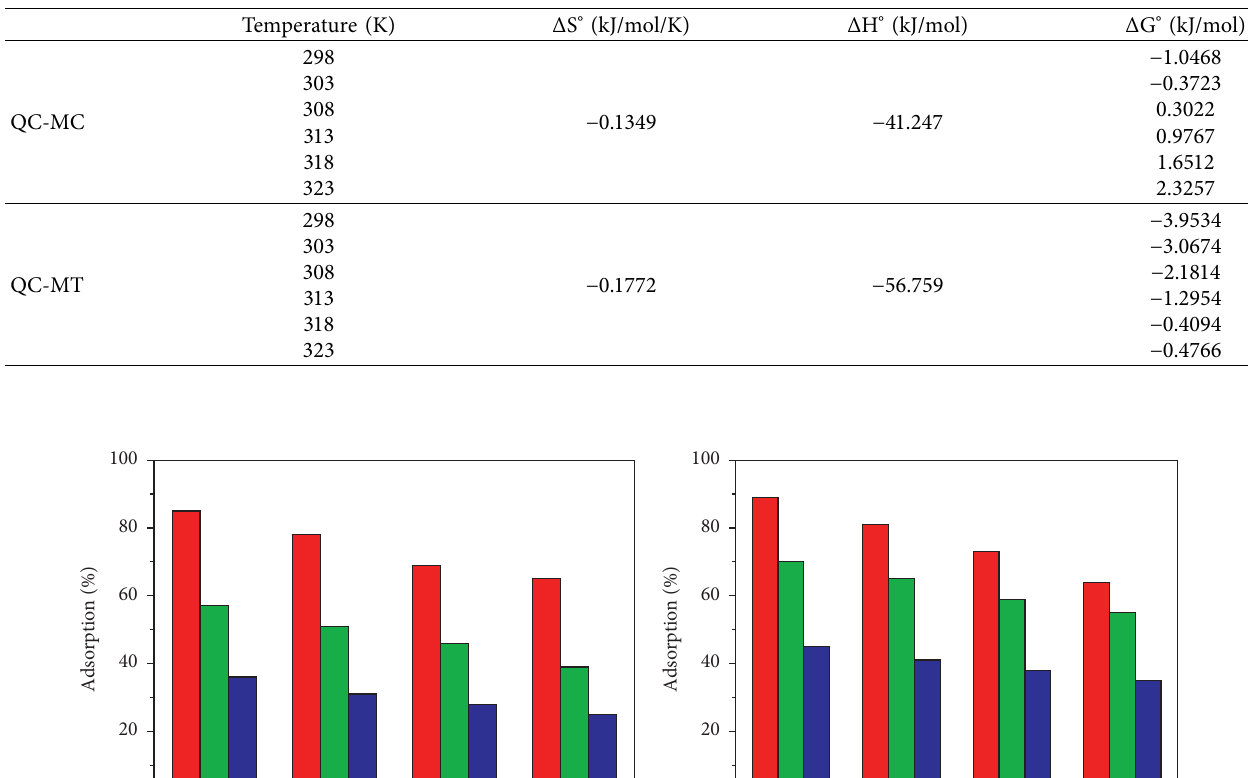
Table 4: Thermodynamic parameters for the adsorption of Cd (II)